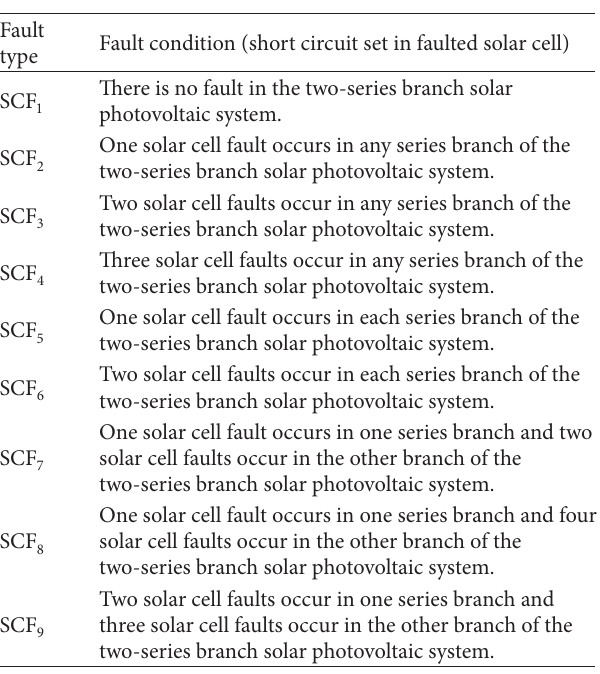
Table 3: Solar photovoltaic system fault